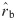
Indirect range restriction (IRR): Effects of a weak, moderate, and strong relationship between predictor X and selection variable Z on the root mean square error (RMSE) of the estimates of the predictive validity (r^b and r^pb).r^b is the estimate of the biserial correlation coefficient for an artificially dichotomous criterion variable, and r^pb is the estimate of the point-biserial correlation coefficient for a naturally dichotomous criterion variable.